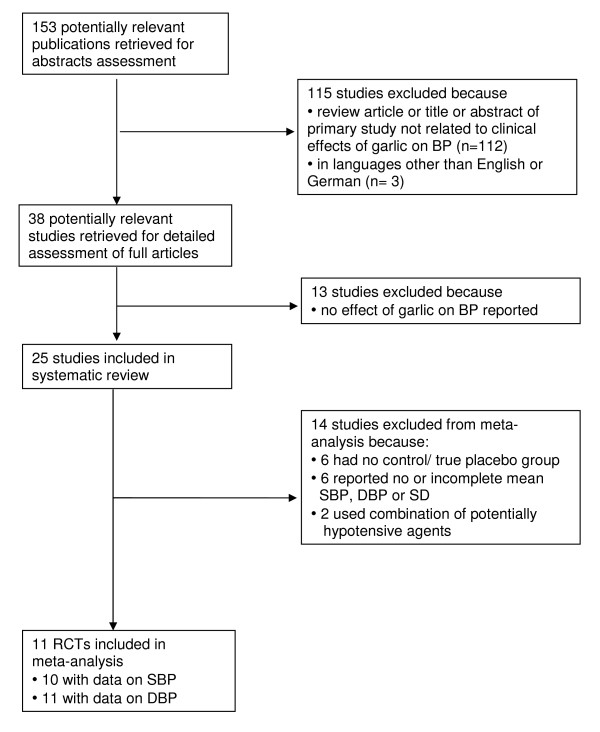
Flow diagram of study selection for systematic review and meta-analysis. Abbreviations: BP, blood pressure; SBP, systolic blood pressure; DBP, diastolic blood pressure; SD, standard deviation; RCT, randomised controlled trial